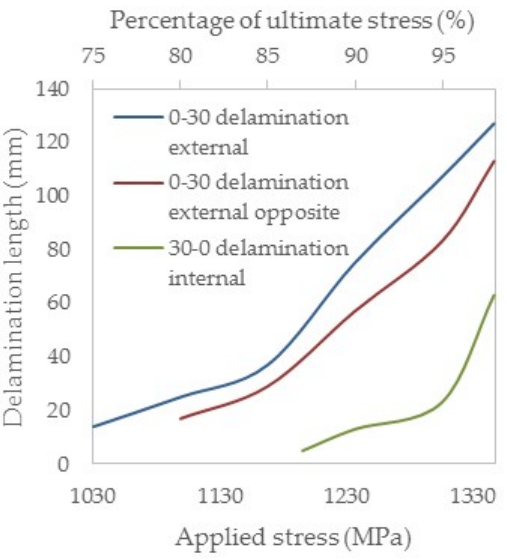
Figure 9. Evolution of delamination length in the [0°/30°] 2s laminates.